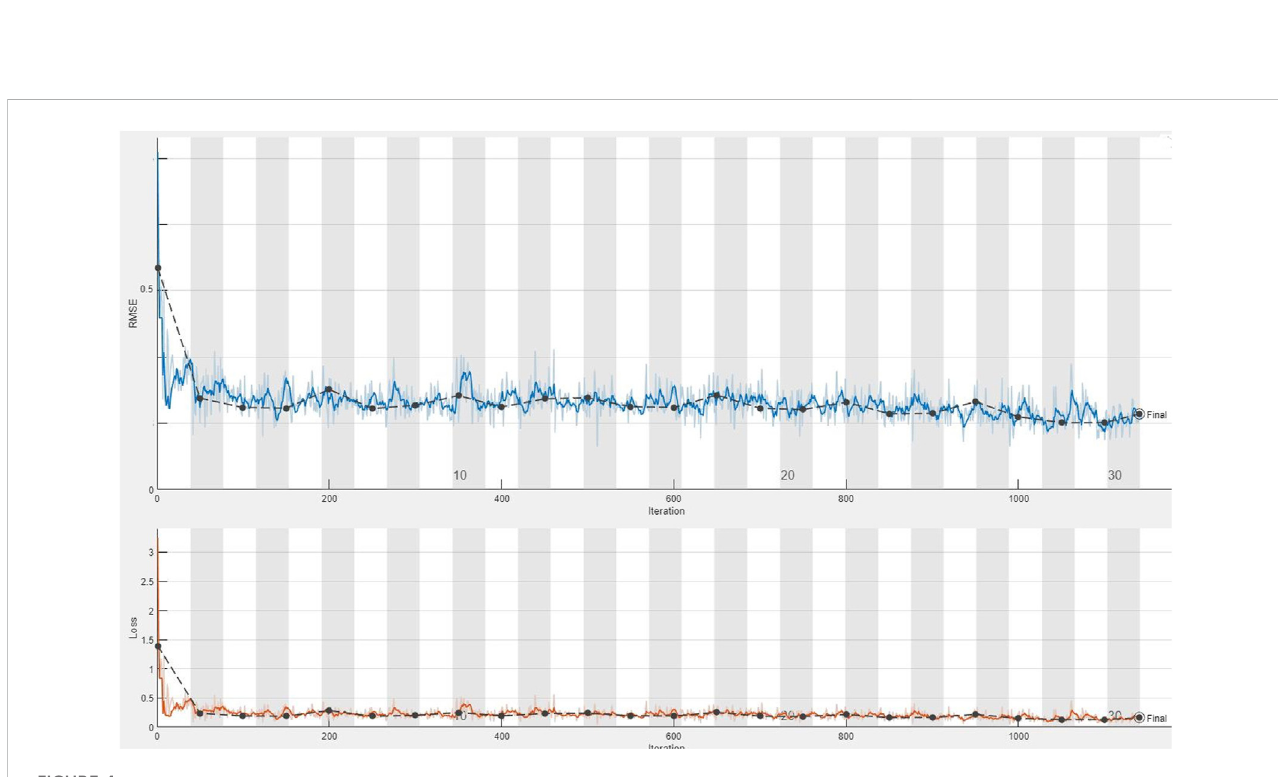
FIGURE 4 Plot of the seventh training of the dataset applying the CDL network for calculating the loss value and RMSE parameter from the fi rst group of geochemical indicator elements (Pb – Zn).